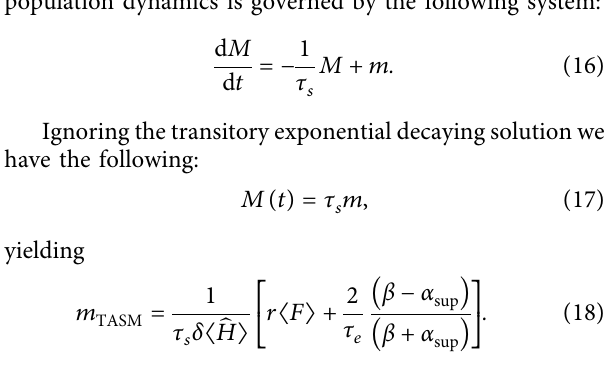
, H , and H . Solid (broken) lines I II III 2